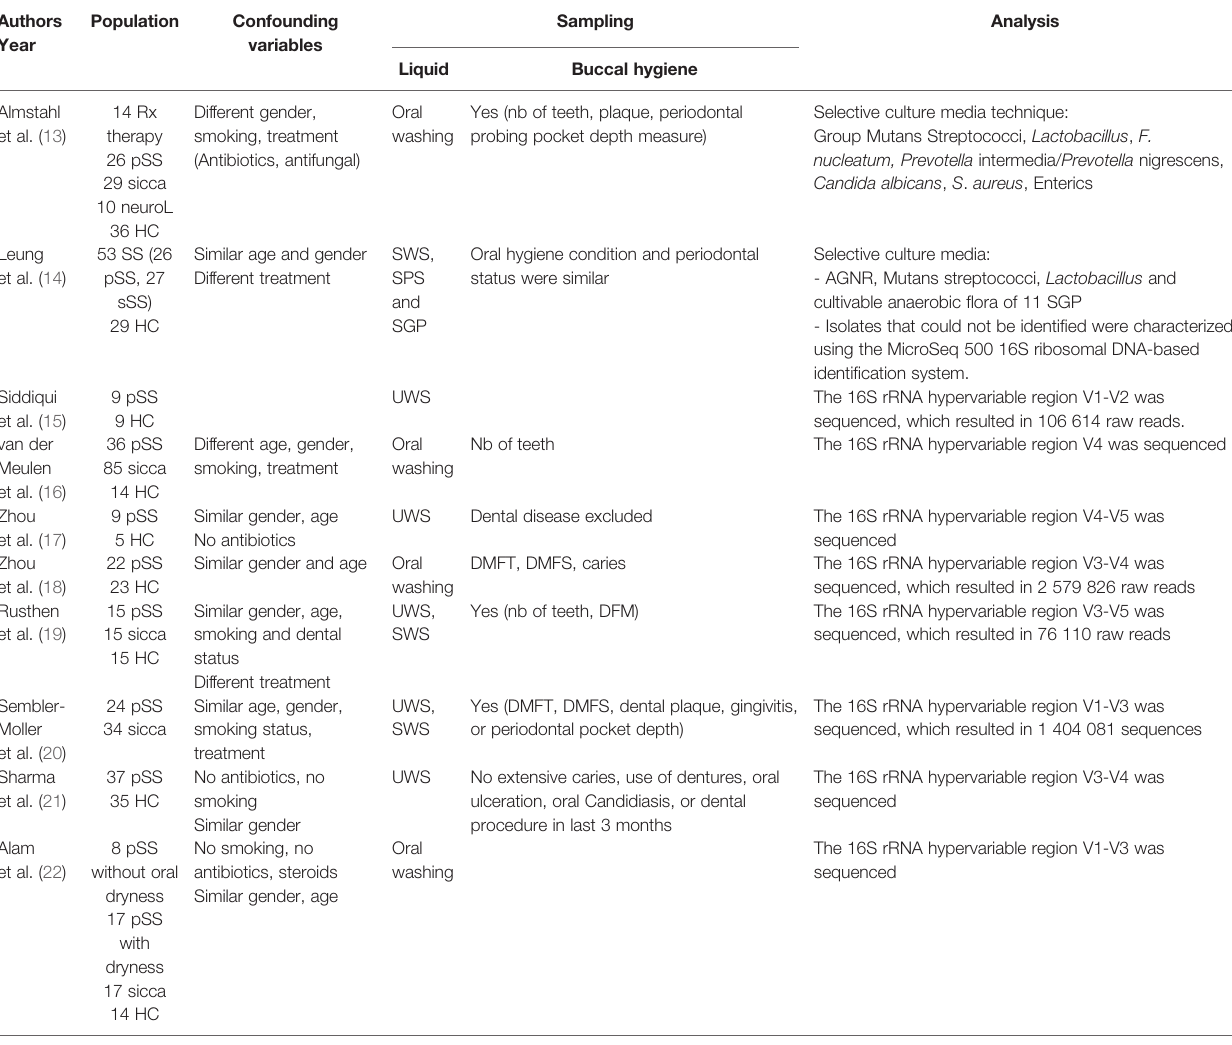
TABLE 1 | Analysis of the methodology of the included studies relying on saliva samples in pSS patients compared to HCs and sicca